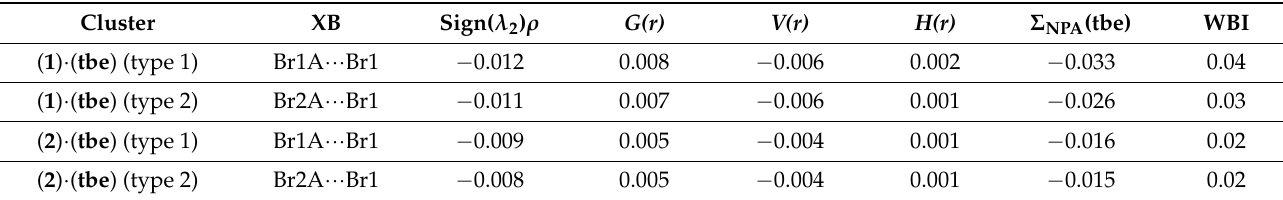
Table 2. Potential energy density V(r) , Lagrangian kinetic energy G(r) and energy density H(r) (Hartree) at the bond critical points (3, − 1), sums of NPA atomic charges on tbe ( Σ NPA (tbe), in q e ), and values of the Wiberg indices (WBI), corresponding to different noncovalent interactions in 1 · tbe and 2 · tbe